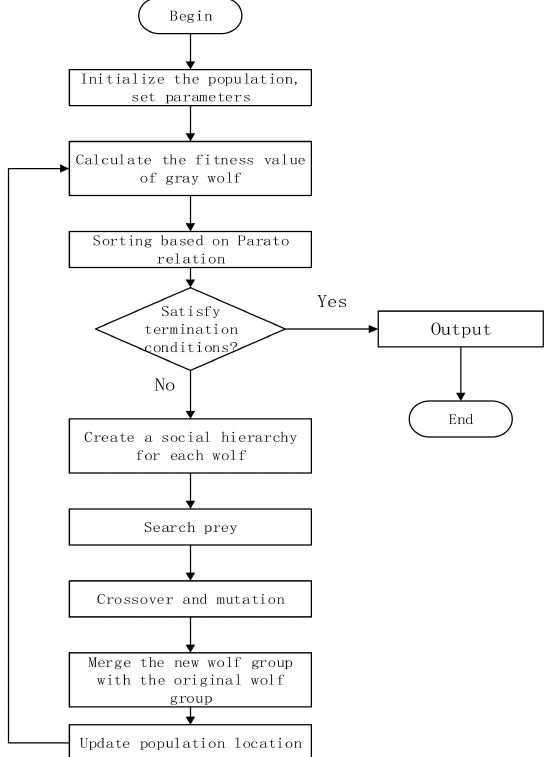
Figure 4. Grey wolf algorithm